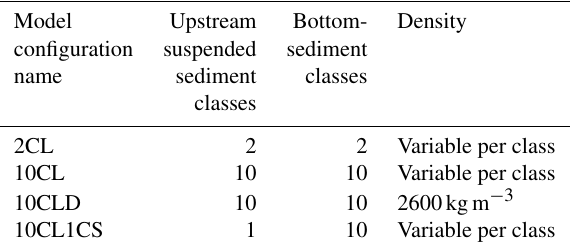
Table 1. Model configurations used in this study. Model Upstream